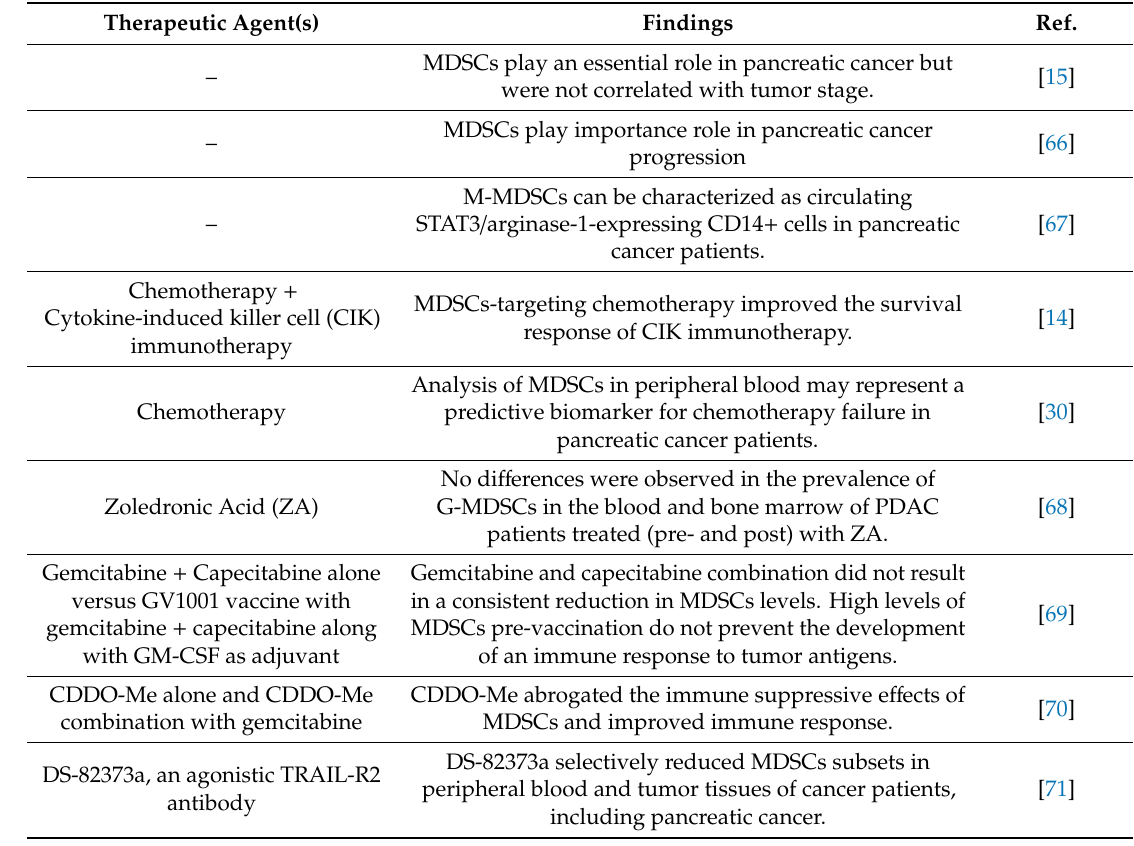
Table 3. Summary of clinical studies defining the role of MDSCs in pancreatic cancer and / or therapy e ffi